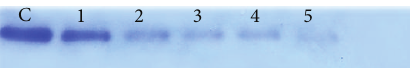
Figure 3: Gelatin zymography of MMP-9 activity. MMP-9 inhi- bition of different concentrations of OSEO after being induced with LPS. Denotation: C (Control), 1 (50 𝜇 g/mL), 2 (100 𝜇 g/mL), 3 (150 𝜇 g/mL), 4 (200 𝜇 g/mL), and 5 (250 𝜇 g/mL) of OSEO. Effect of OSEO on downregulation of